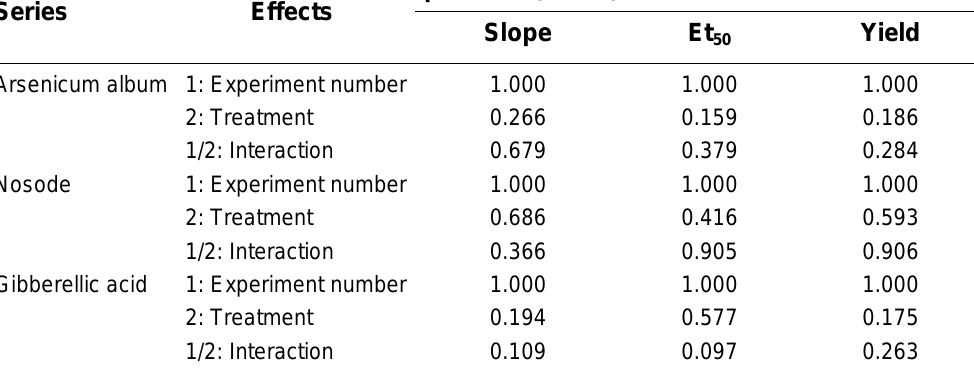
, and Yield) of S. 50